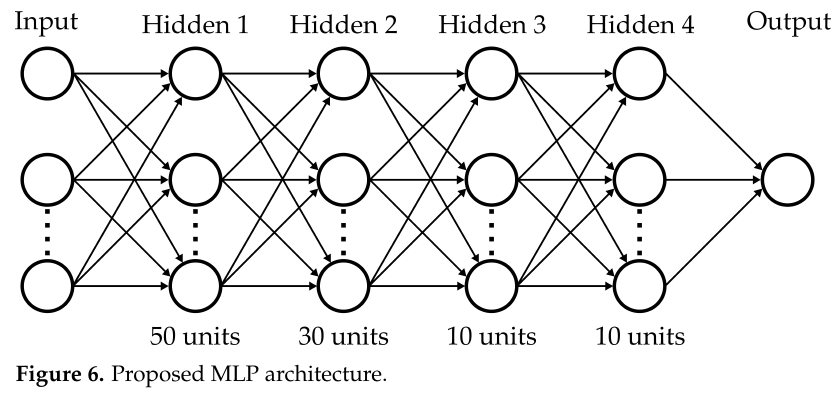
Figure 6. Proposed MLP architecture.